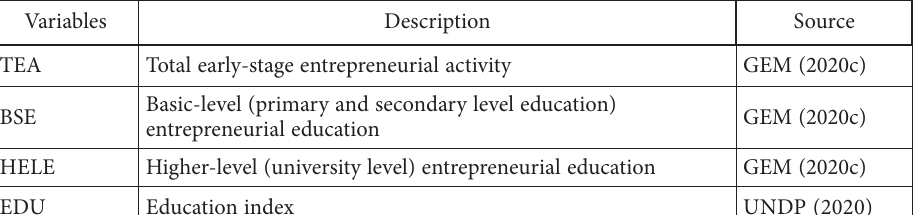
Variables Description